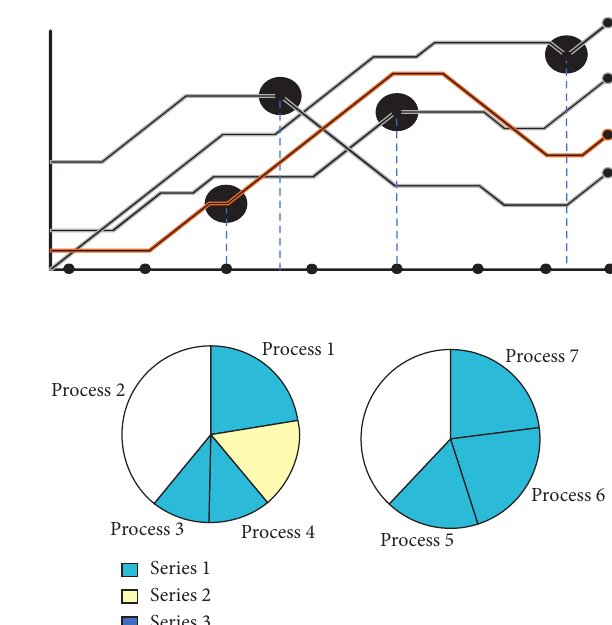
Figure 10: The filtering effect diagram of the two algorithms in the target maneuvering